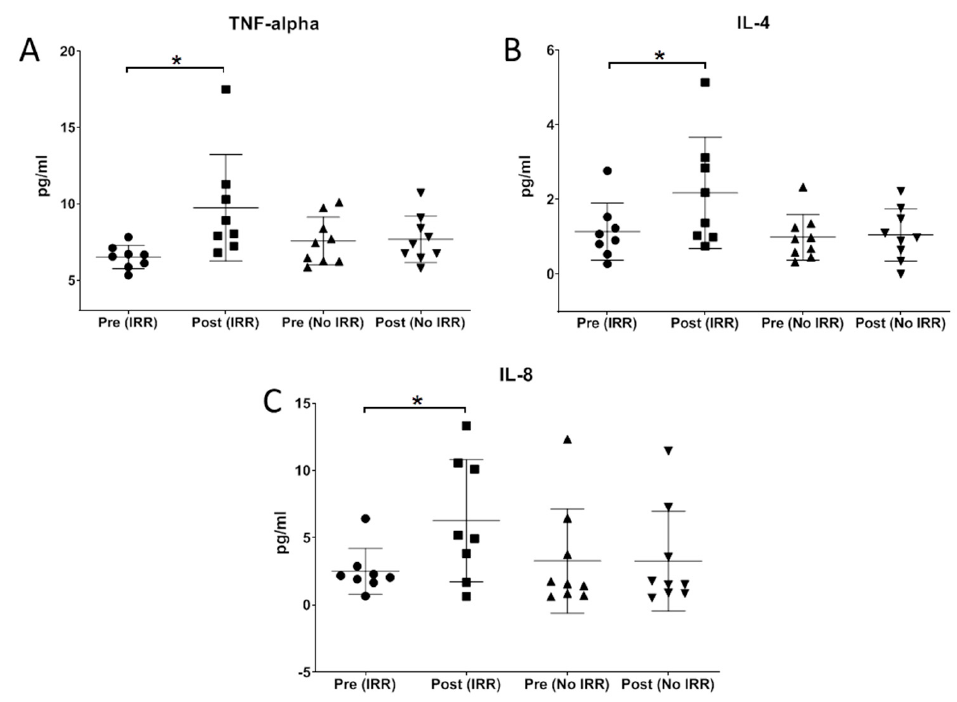
Figure 3. Cytokine analysis pre- and post-infusion time points from FD patients with IRRs and without IRRs. ( A – C ) Quantification of TNF- α , IL-4 and IL-8 in plasma samples at pre- and post-infusion